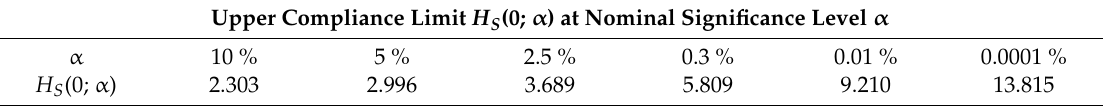
Table 9. Upper limits of the probability intervals (cid:1834) (cid:3020) (cid:3435)(cid:1840)(cid:3553);(cid:2009)(cid:3439) and (cid:1834) (cid:3021) (cid:3435)(cid:1840)(cid:3553);(cid:2009)(cid:3439) = (cid:1834) (cid:3020) (cid:3435)(cid:1840)(cid:3553);(cid:2009) 2⁄ (cid:3439) as derived from the single (Section2.7.2) and the two-hypotheses (Appendix B) tests for (cid:1840)(cid:3553) observed fibers and a per-tail significance levels of (cid:2009) = 5 % and (cid:2009) 2⁄ = 2.5 % , respectively. The single-test upper limit (cid:1834) (cid:3020) is by a fraction of δ(ΔH) ≔ ((cid:1834) (cid:3021) − (cid:1834) (cid:3020) )/(cid:1834) (cid:3020) smaller than the upper limit (cid:1834) (cid:3021) from twin testing. Upper Probability Interval Limits for (cid:2170) (cid:3553) Observed Fibers and a Significance Level (cid:2235) = (cid:2782) % (cid:2170)(cid:3553)